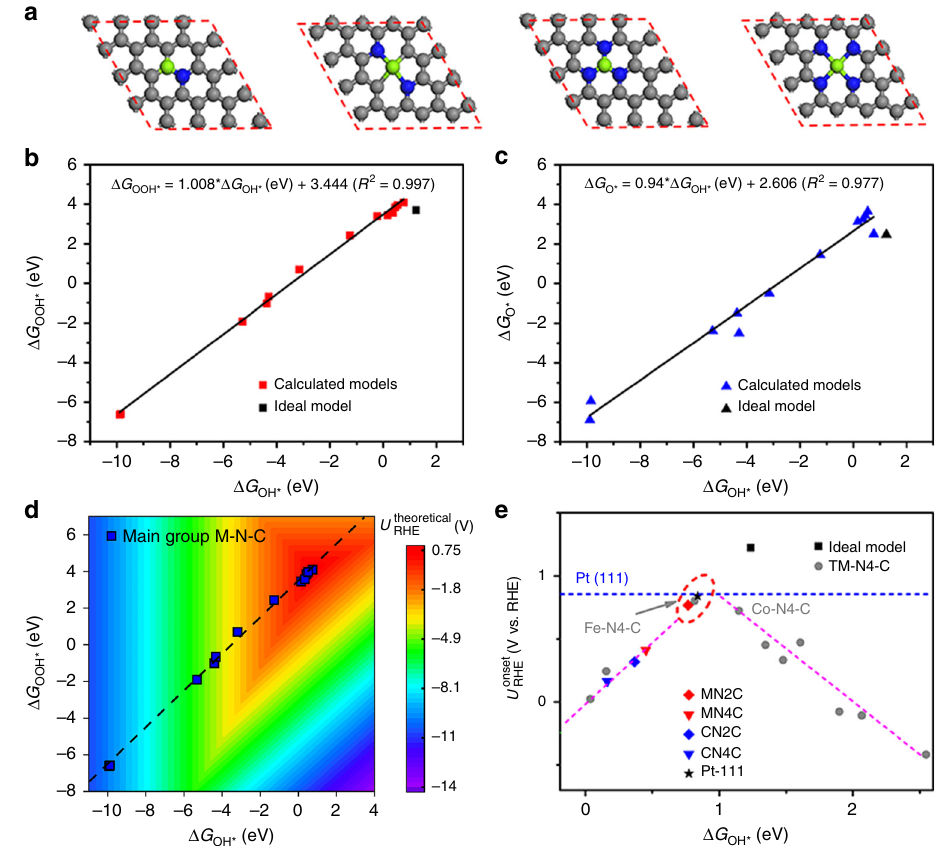
Fig. 1 The calculation models and results. a The geometric con fi gurations of Mg embedded in graphene framework predominantly existing as single atoms coordinated with different numbers (from 1 to 4) of nitrogen atoms. The green, blue, and gray balls represent metal, N and C atoms, respectively. b Adsorption free energies of OOH as a function of that of OH for models of Mg, Al, and Ca coordinated with different numbers of pyridine nitrogen atoms embedded in graphene matrix. c Adsorption free energies of O versus that of OH for all models. d The two-dimensional volcano map about theoretical onset potential versus adsorption free energies Δ G OH* and Δ G OOH* on main group metal cofactors (M – N – C). e The zoomed-in view of the onset potential versus Δ G OH* in the region close to the performance ceiling of models and transition metal cofactors (TM – N4 –